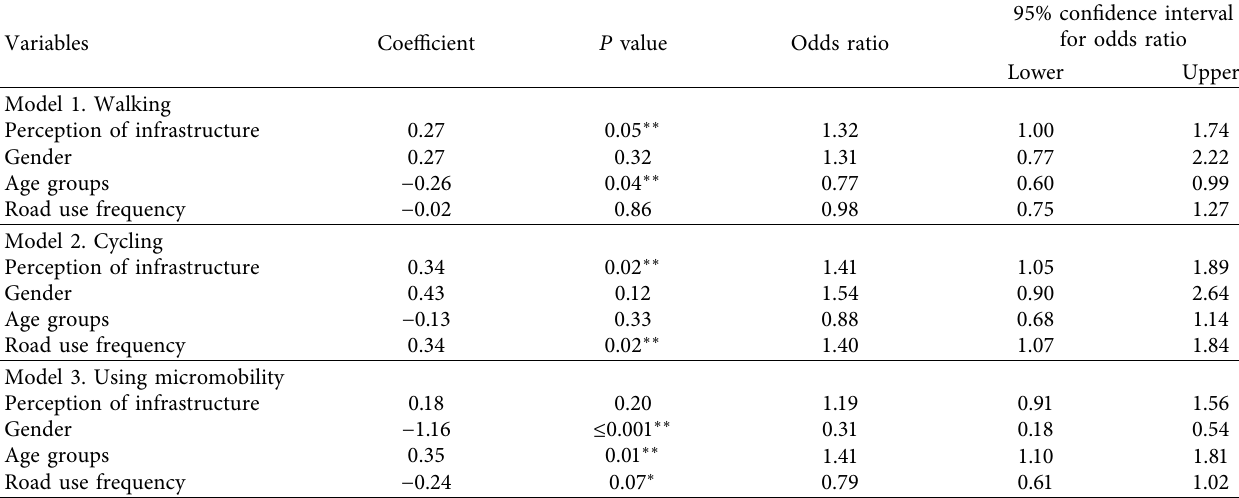
Table 4: Ordered logit models for comfort